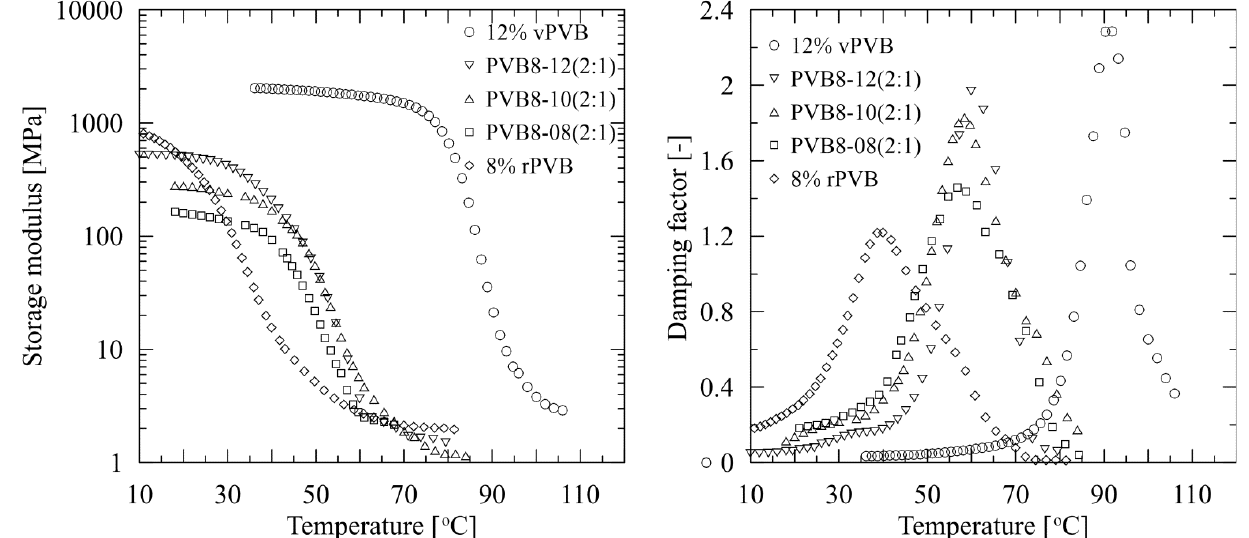
Figure 12. Temperature dependent behavior of storage modulus ( left ) and damping factor (tan delta) ( right ) of nonwoven rPVB and blended PVB nanofibrous webs, and vPVB film.